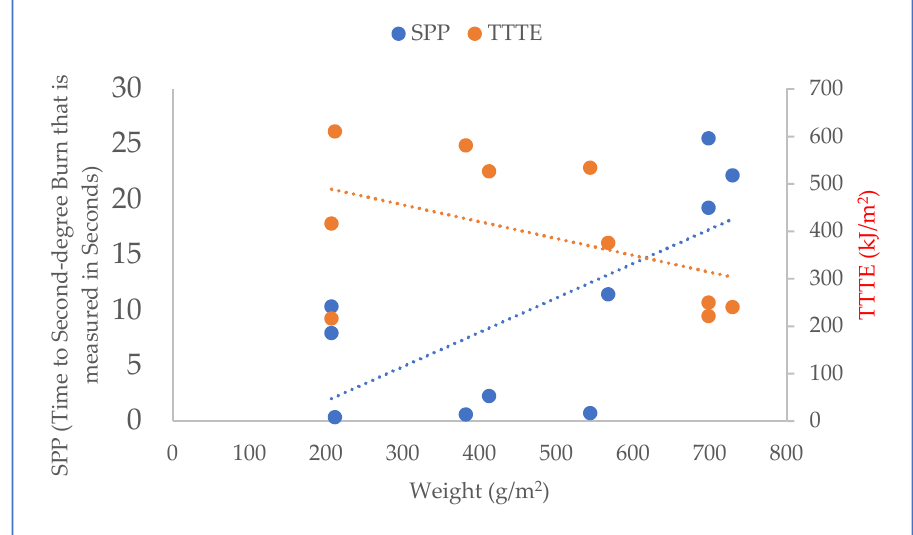
Figure 5. Relationship plot of weight with SPP and TTTE.